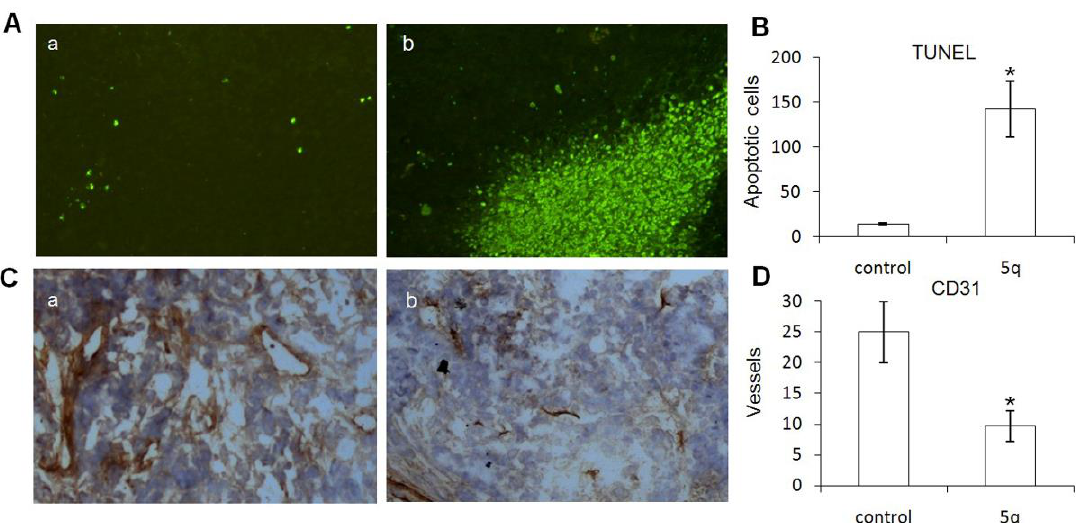
Figure 2. 5q induces the apoptosis of cancer cells and inhibits angiogenesis. ( A ) 5q induces the apoptosis of cancer cells. ( a ) Scattered positive signals in the control group. ( b ) Clustered positive signals in 5q -treated group. ( B ) Quantitative analysis of the apoptotic cells. Data are represented as means ± standard deviation of cells per hpf (* p < 0.05) (200 × ). ( C ) 5q inhibits angiogenesis. CD31 immunohistochemistry in the frozen sections from the control group (a) and 5q -treated group (b). ( D ) Quantitative analysis of the vessel density. Data are represented as means ± standard deviation of vessels per hpf (* p < 0.05) (200×).